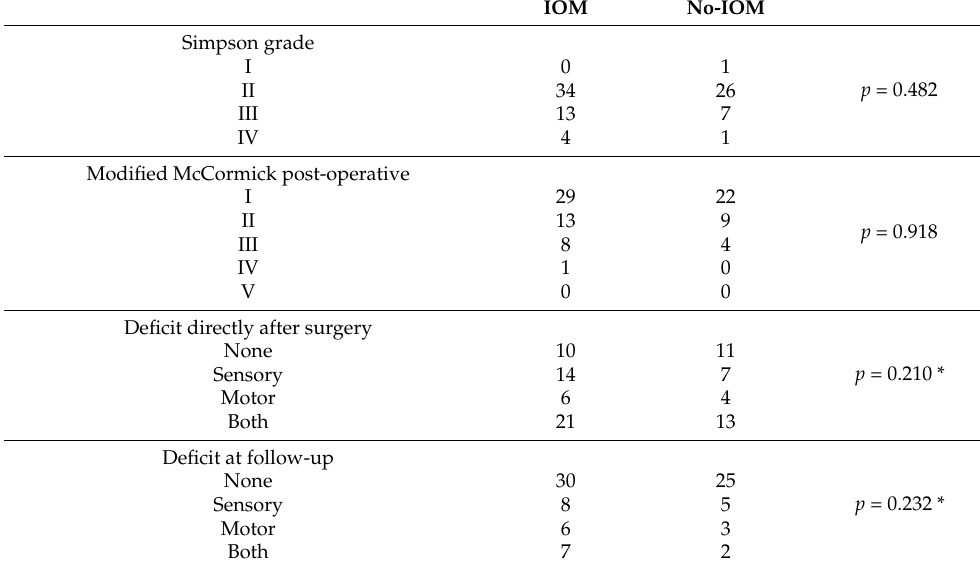
Table 5. IOM versus no-IOM, after